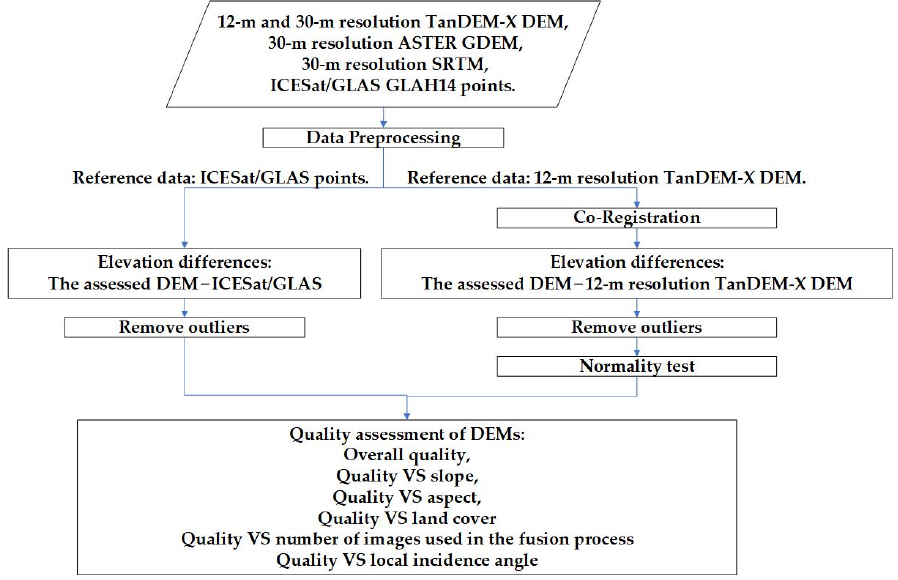
Figure 2. The general workflow of this